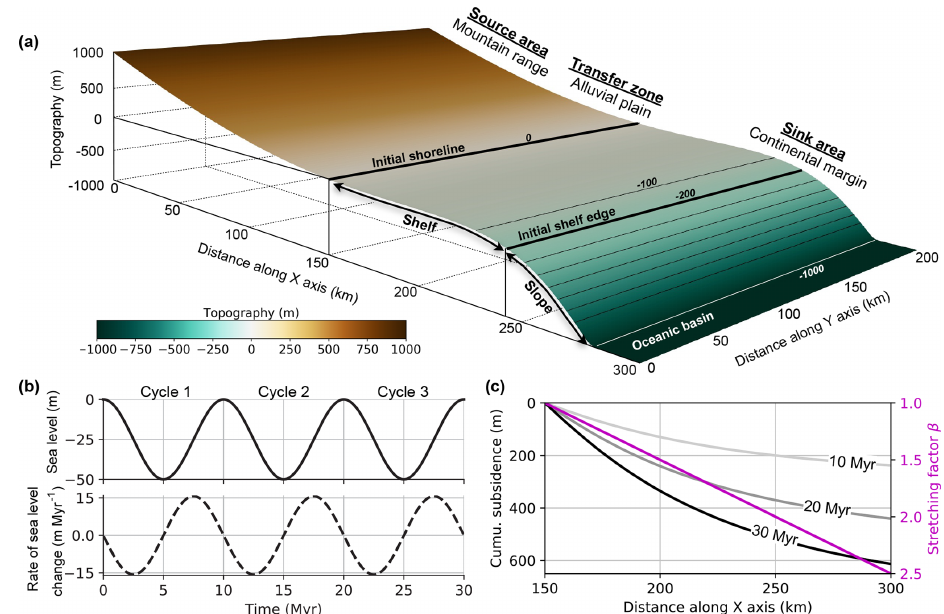
Figure 4. Model setup. (a) The initial surface elevation of the mountain region ranges from 200 to 1000m over a width of 100km, while the elevation of the alluvial plain ranges from 0 to 200m over a width of 50km. The sink area includes a continental margin in which the elevation of the continental shelf ranges from − 250 to 0m over a width of 80 km, the elevation of the continental slope ranges from − 1000 to − 250m over a width of 40km and a flat oceanic basin whose depth is − 1000m over a width of 30km. Black lines are isobaths with an interval of 100m. The initial elevations of shoreline and shelf edge are 0 and − 200m. (b) Eustatic sea level and its rate of change over 30Myr. The eustatic sea level scenario modelled using a sinusoidal curve consisting of three 10Myr cycles of 50m peak-to-peak amplitude. (c) Distance-dependent stretching factor β and the resulting thermal subsidence at 10, 20 and 30Myr across the continental